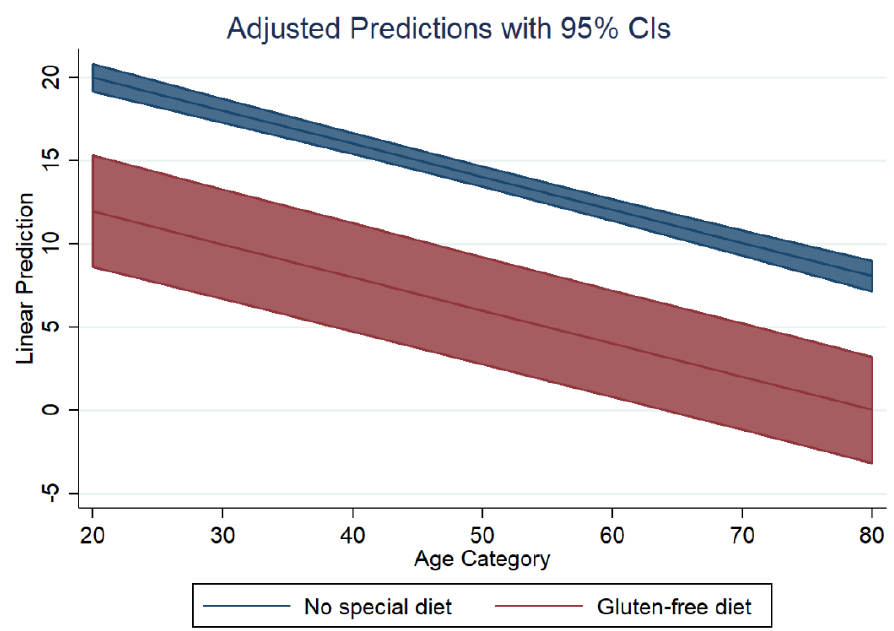
predicted values of NEAP F for both diet groups (GFD in red, no special diet in blue) at all possible increments of 10 units in age.